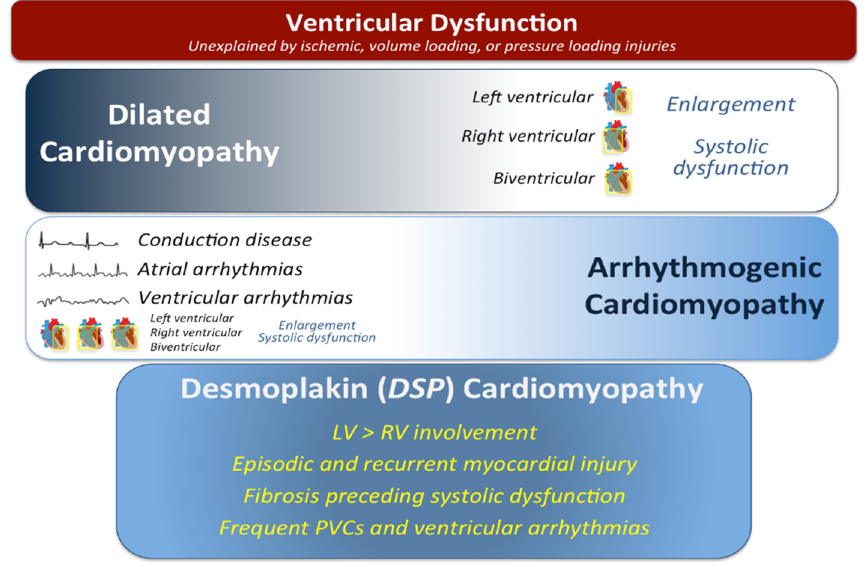
Figure 1. Characteristics of the clinical presentations of dilated cardiomyopathy (DCM), arrhythmogenic cardiomyopathy (ACM), and desmoplakin cardiomyopathy. Dilated cardiomyopathy is typically characterized by ventricular systolic dilation and dysfunction in the absence an ischemic, valvular, hypertensive, or other systemic insult. Arrhythmogenic cardiomyopathy is distinguished by a clinical presentation with documented or symptomatic arrhythmia or conduction disease. This presentation can occur concomitantly with ventricular dilation and/or dysfunction. Desmoplakin cardiomyopathy presents with features of both DCM and ACM along with unique features such as episodic and recurrent myocardial injury. Abbreviations: DSP = desmoplakin; LV = left ventricular; RV = right ventricular; PVCs = premature ventricular contractions.